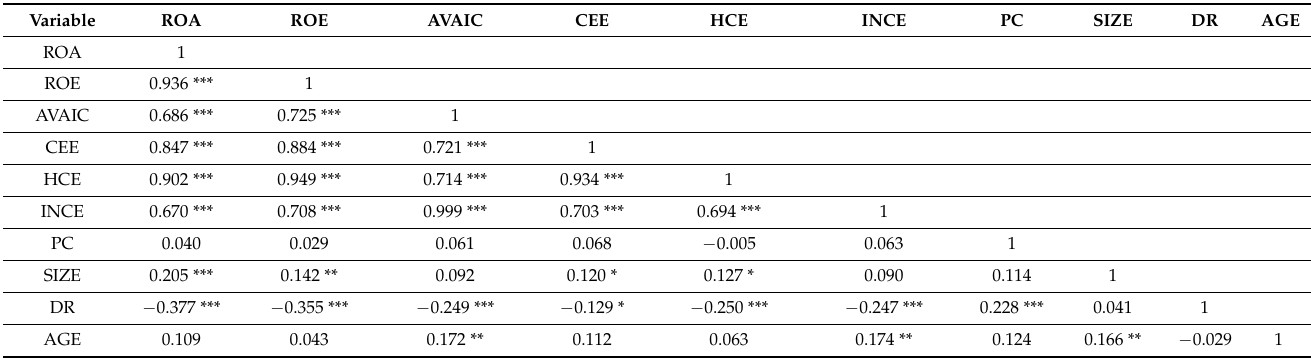
Table 6. Correlation analysis of the AVAIC model.